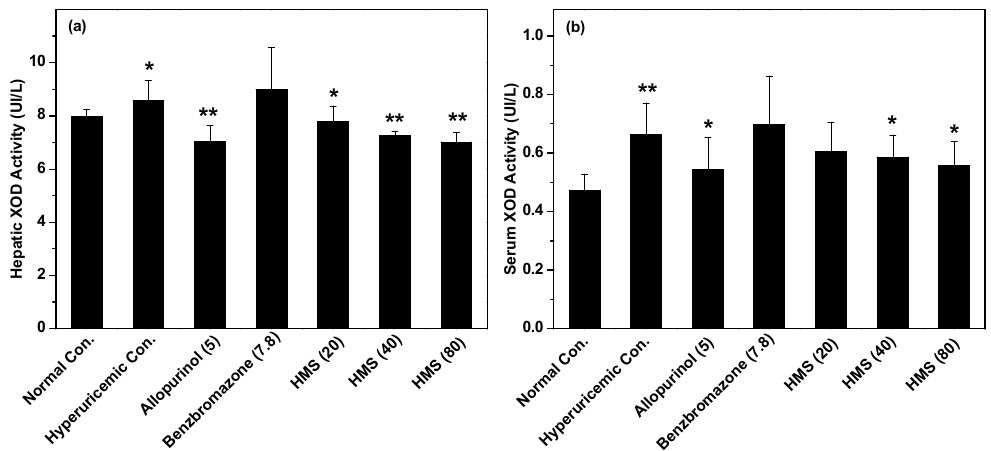
Figure 5. The influence of HMS against XOD in vivo: ( a ) hepar and ( b ) serum. Data were expressed as mean ± SD; n = 8. Statistical analysis by one-way ANOVA followed by two-tailed Student’s t -test; * p < 0.05, ** p < 0.01 versus the normal control.